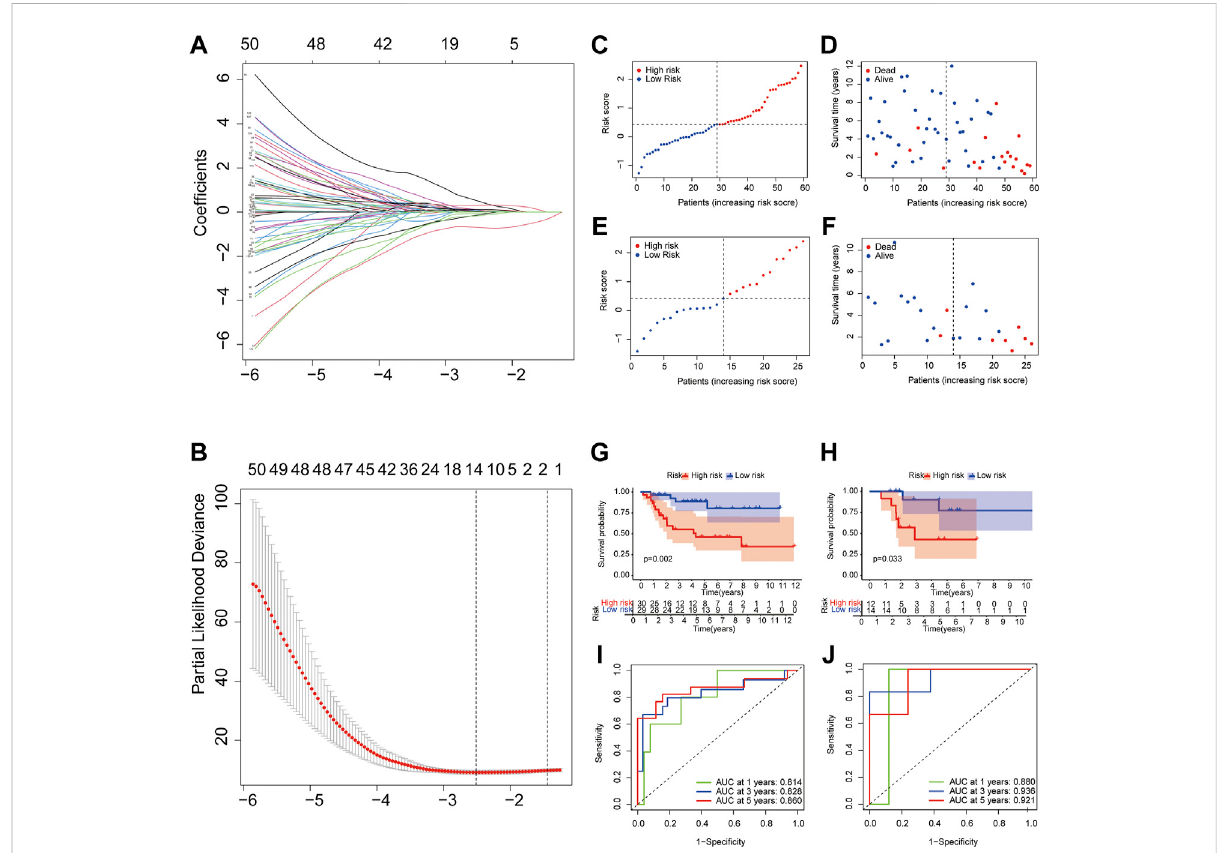
FIGURE 10 Construction and validation of pyroptosis risk signature. (A,B) LASSO regression and cross-validation of genes; (C,E) OS patients assigned in subtypesbythemedianvalueofthepyroptosisriskscoreintraining (C) andtestingcohorts (E) ; (D,F) Distribution ofsurvivalstatusinthehighandlow pyroptosisriskgroupfromtrainingcohort; (G,H) Overallsurvivalcurvesforpatientswithhighandlowpyroptosisriskscoresintraining (G) andtesting cohorts (H) ; (I,J) ROC curves of the pyroptosis risk signature indicating the predictive ability in training (I) and testing cohorts (J)